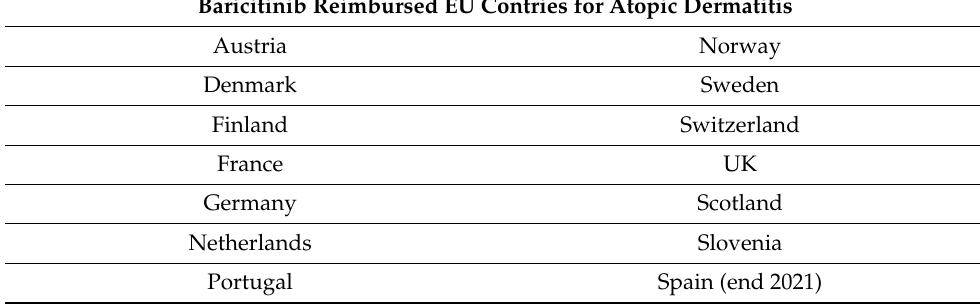
Table 4. List of European countries in which baricitinib is already reimbursed in treating atopic der-